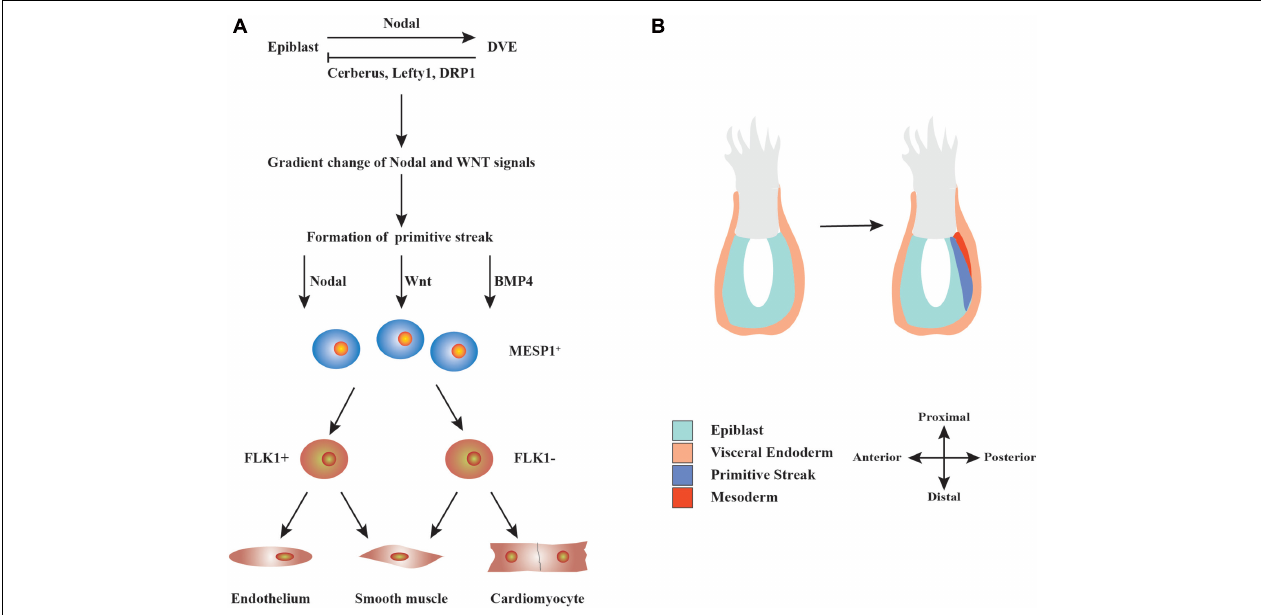
FIGURE 1 | Schematic diagram of the development of heart cells in vivo . (A) Mutual regulation between epiblast and distal visceral endoderm (DVE) through Nodal, Cerberus, Lefty1, and DRP1 signals leads to a gradient distribution of the concentrations of Nodal and WNT, which results in the formation of primitive streak. During primitive streak migration, a small number of cells express mesoderm posterior protein 1 (MESP1), marking the beginning of heart development. MESP1 + cells finally differentiate into various cells that form the heart, such as endothelium, smooth muscle, and myocardium. (B) The migration of the primitive streak from posterior to anterior also marks the beginning of gastrulation, a crucial event in embryonic development. During this period, the embryo becomes a trilaminar embryonic disk, and the heart develops from the